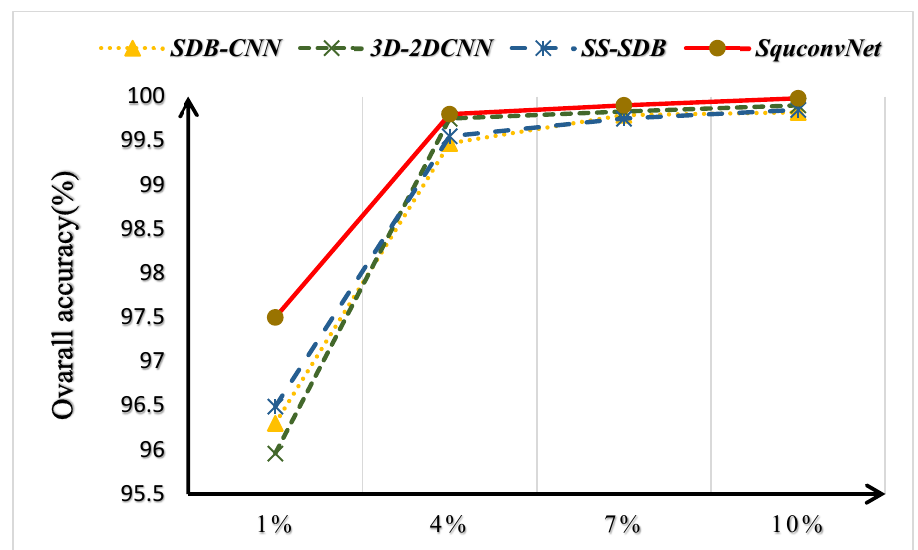
Figure 12. The Overall Accuracy of the different proposed models on the UP dataset at different training samples.